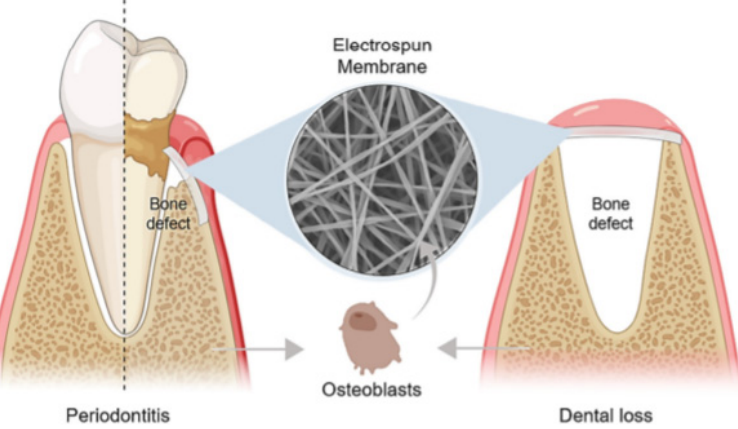
Figure 1. The application of an electrospun membrane for guided tissue/bone regeneration (GTR/GBR) in periodontitis and dental loss, respectively. Reprinted from Ref. [10].